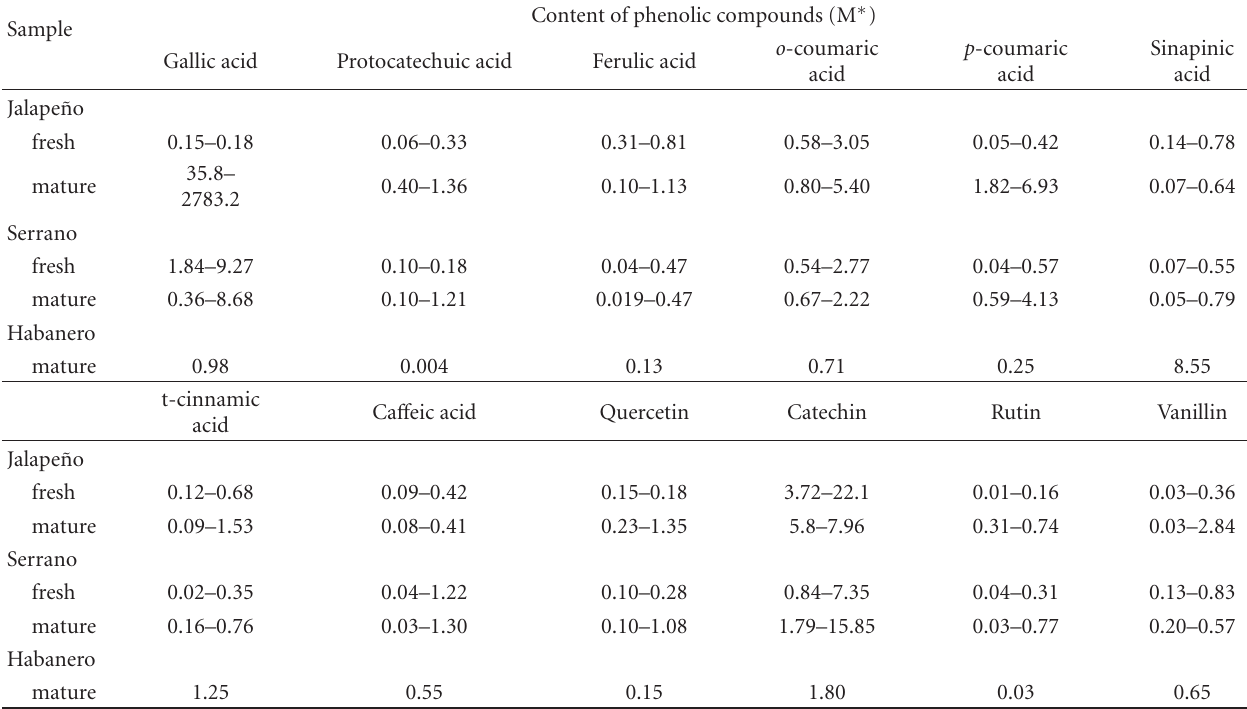
Table 6: Content of phenolic compounds in chilli